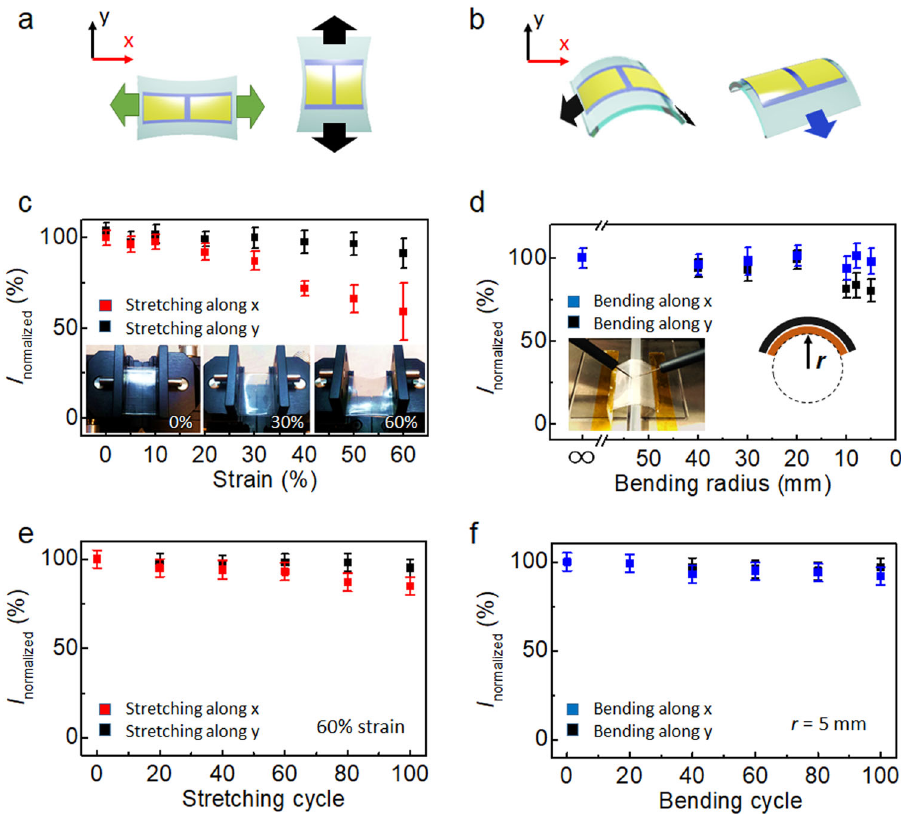
Fig. 4 Stretching and bending tests of the NW PD device. An illustration of the ( a ) stretching test and ( b ) bending test executed in two different directions. c The normalized photocurrent as a function of strain. The inset shows a series of optical images under different stretching conditions. d The normalized photocurrent as a function of the bending radius of curvature. e The performance of the PD as a function of stretching cycle with a strain of 60%. f The endurance of the PD performance as a function of bending cycle at a bending radius of ~5 mm. Note that the error bars indicate standard deviation of the current measured from >10 different